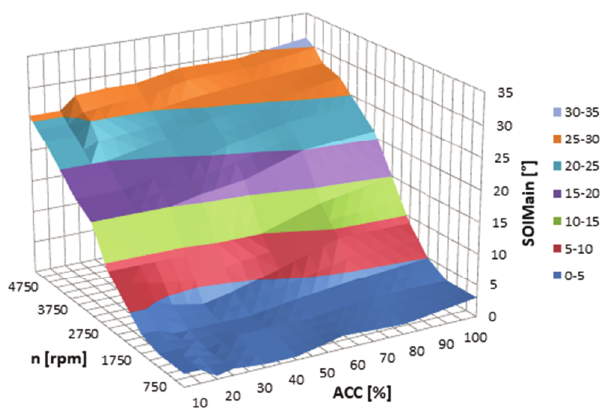
Fig. 11. Visual representation of the injection advance angle control algo- rithm for the Main